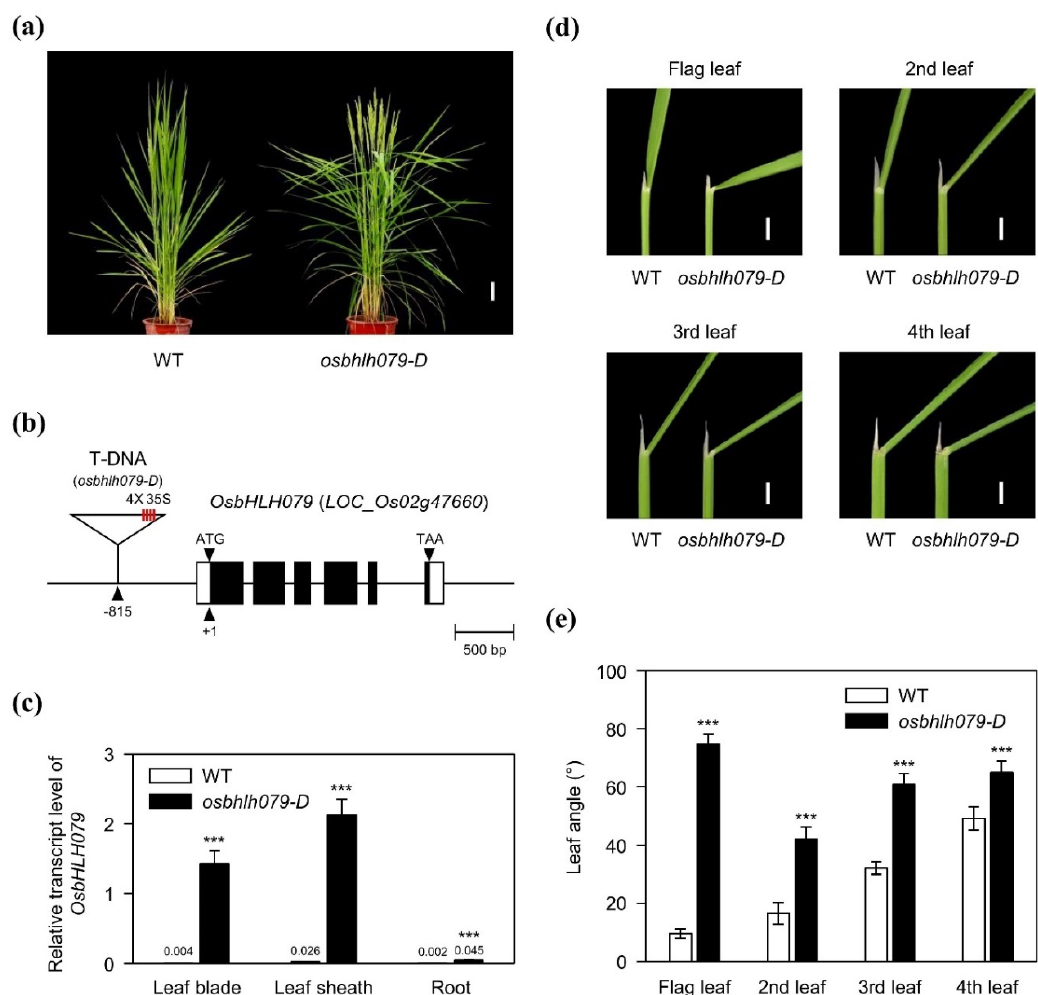
Figure 1. Phenotypic characterization of the osbhlh079-D mutant in rice. ( a ) Phenotypes of wild-type (WT) and osbhlh079-D at heading stage in plants grown under natural long day (NLD) conditions in the paddy field. Scale bar = 10 cm. ( b ) Schematic diagram illustrating the position of the T-DNA insertion in OsbHLH079 (LOC_Os02g47660). Open boxes and filled boxes represent the untranslated region and coding sequence of OsbHLH079 , respectively. ( c ) Comparison of the OsbHLH079 transcript levels between 3-week-old plants of WT and osbhlh079-D grown under natural sunlight in the greenhouse. The transcript level of OsbHLH079 was measured by RT-qPCR and normalized to UBQ5 . Means and standard deviations were obtained from five biological replicates. ( d ) The leaf angle phenotypes of WT and osbhlh079-D at heading stage grown under NLD conditions in the paddy field. Scale bar = 1 cm. ( e ) Statistical analysis of leaf angles between WT and osbhlh079-D at heading stage grown under NLD conditions in the paddy field. Means and standard deviations were obtained from ten biological replicates. Significant differences between means were analyzed using Student’s t -test (*** p < 0.001). These experiments were repeated twice with similar results.